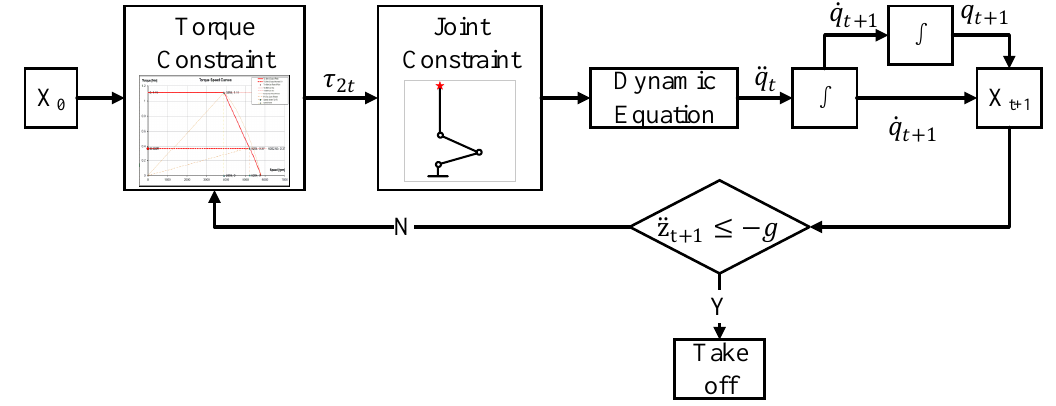
Figure 4. The control system for choosing an appropriate reduction radio for motor